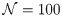
Dynamics of encounter networks.(a) Average degree 〈k(t)〉 and (b) average clustering 〈C(t)〉 as a function of time for different values of α. The results are obtained by Monte Carlo simulation of N = 500 random walkers visiting N=100 random locations in the region [0, 1] × [0, 1] in R2 following the strategy defined by the transitions probabilities given by Eq (1) with R = 0.17. For each time, we compute the adjacency matrix considering a memory M = 50 and a minimum of c = 3 contacts to establish a link between two nodes. (c) Degree probability distribution P(k) for encounter networks in the stationary limit for different values of α. We analyze the structure of the networks at time t = 200 for which the temporal evolution is stationary. All the results are obtained considering the ensemble average from 100 realizations of the system.